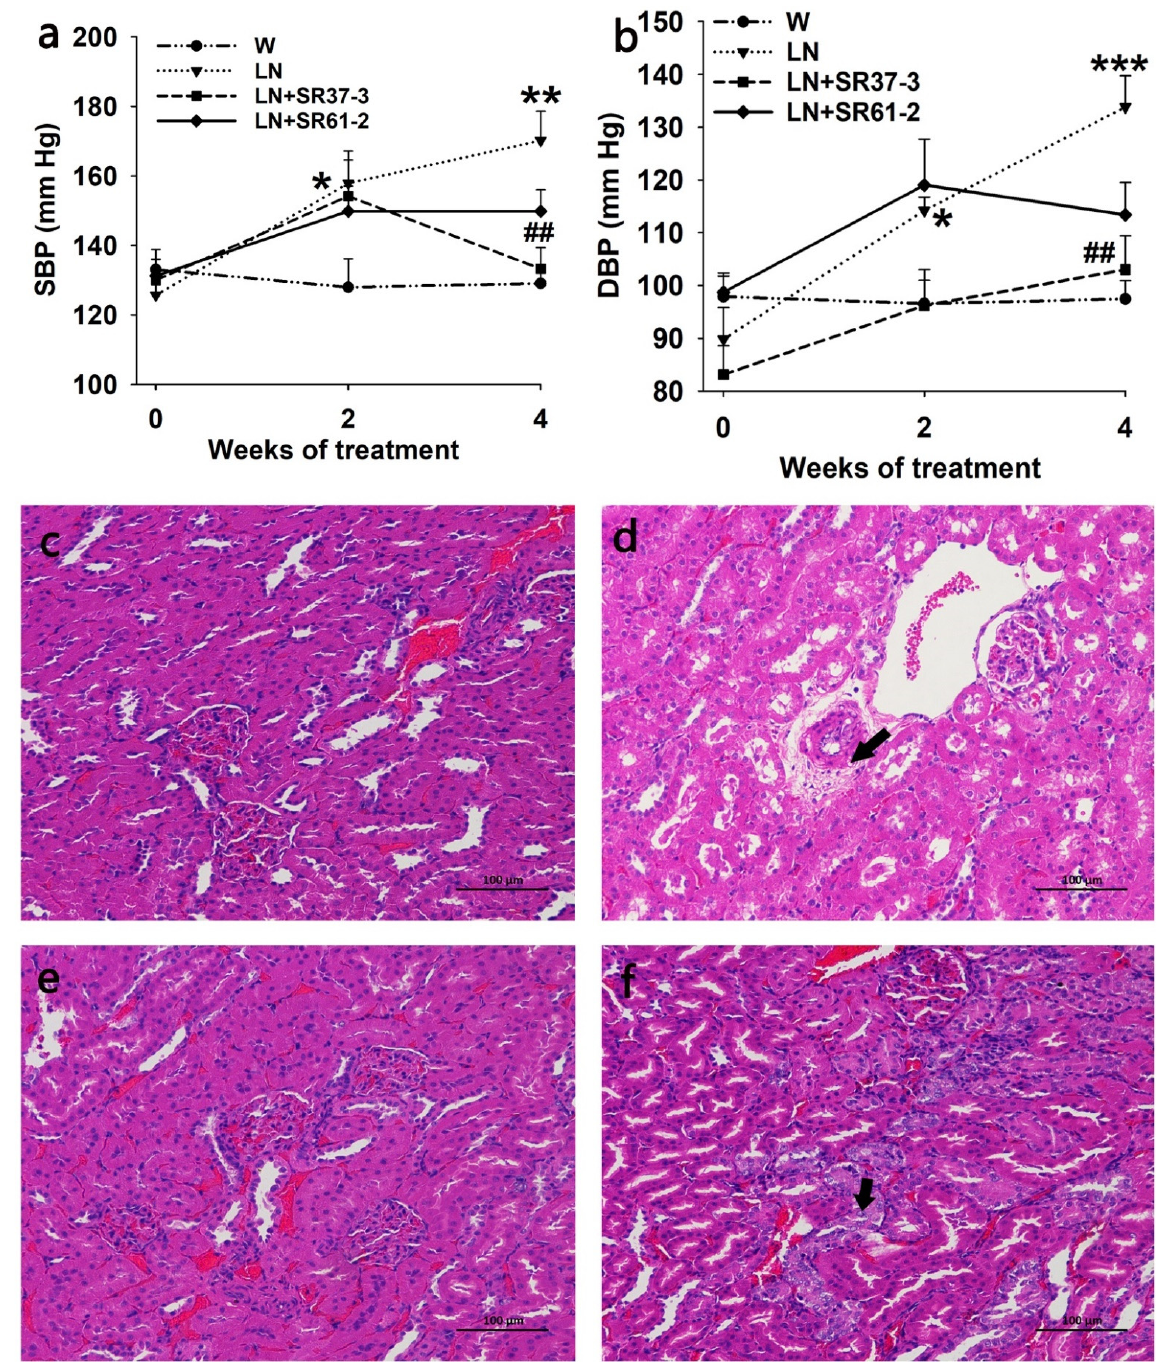
Figure 1. Effects of milk fermented by the Lactiplantibacillus plantarum strain SR37-3 (PFM-SR37-3) and milk fermented by the Lactiplantibacillus plantarum strain SR61-2 (PFM-SR61-2) on blood pressure and the kidneys in hypertensive rats. The effects of long-term PFM administration on SBP ( a ) and DBP ( b ). *, ** and *** indicate p < 0.05, p < 0.01 and p < 0.001 , respectively, compared with the W control group, ## indicates p < 0.01, compared with the LN control group. The lesion is indicated by the arrow. cont W: animals not treated with N G -nitro-L-arginine methyl ester (L-NAME) receiving standard chow; cont LN: L-NAME treated rats receiving standard chow; LN + SR37-3: L-NAME treated rats receiving PFM-SR37-3; LN + SR61-2: L-NAME treated rats receiving PFM-SR61-2. The HE staining of the kidneys; ( c ) W group (control group), ( d ) LN group (model group), ( e ) LN + SR37-3 group and ( f ) LN + SR61-2 group. Values are expressed as mean ± SE ( n = six